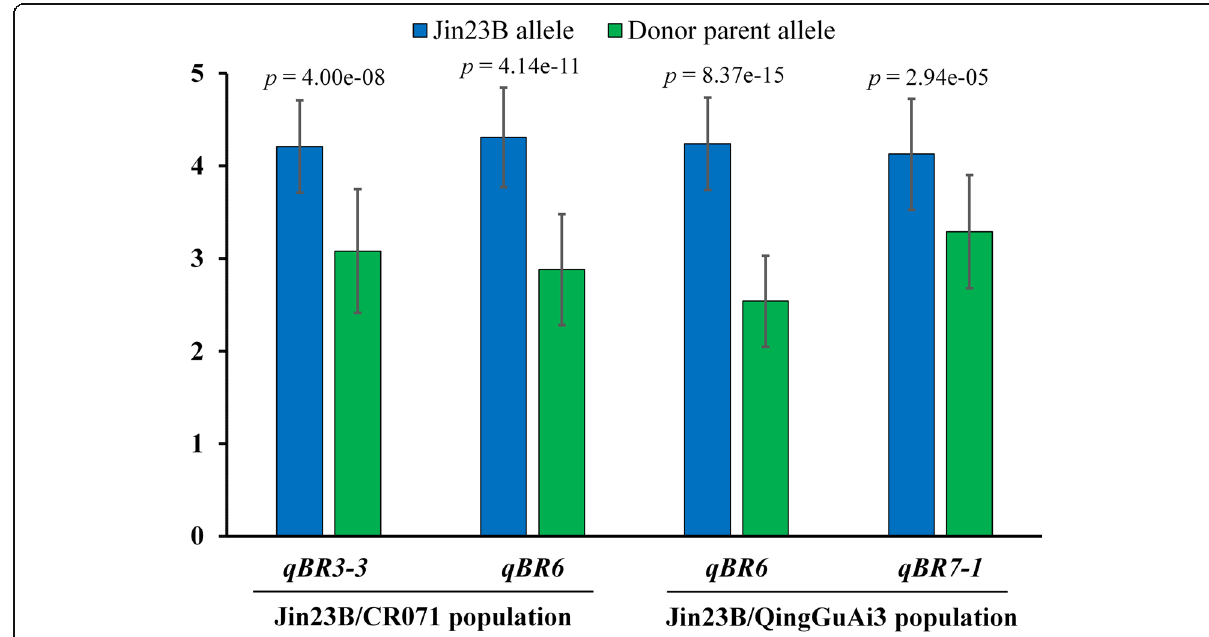
Fig. 5 Genetic effects of qBR3 – 3 and qBR6 from CR071 and qBR6 and qBR7 – 1 from QingGuAi3. Blue bar represent alleles from Jin23B, Green bar represent alleles from donor parent. P -value based on two-way t-test . Error bars are based on standard deviation of each